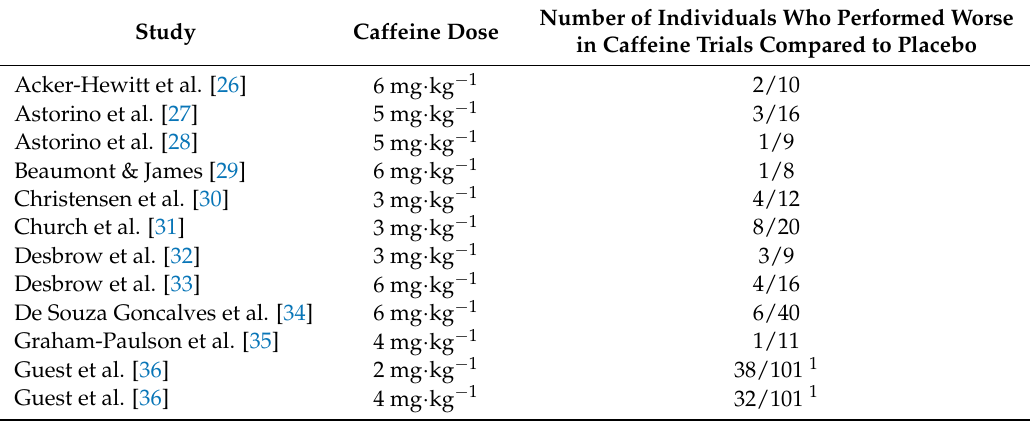
Table 1. Time-trial studies investigating ergogenicity of caffeine which reported individual